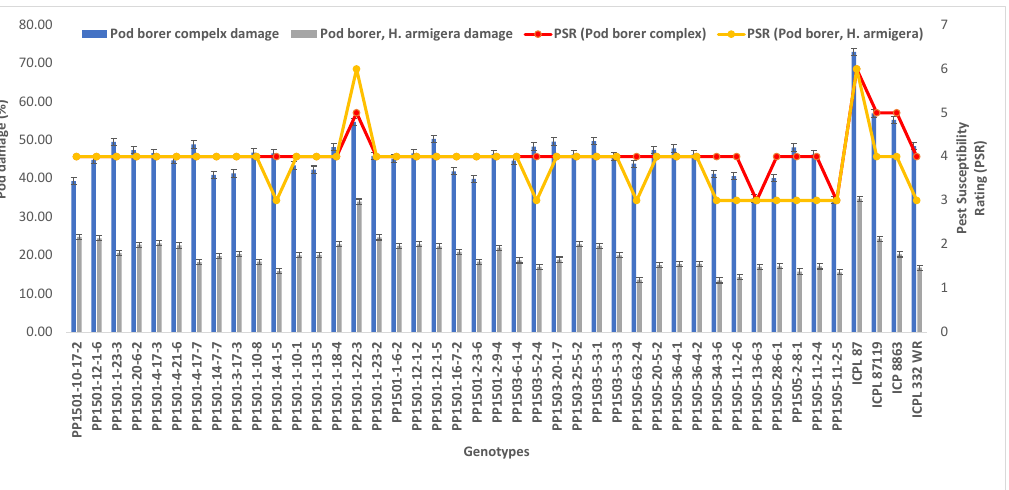
Figure 5. Pest susceptibility rating (PSR) of selected 39 lines based on pod borer complex and pod borer ( H. armigera ) damage over years.